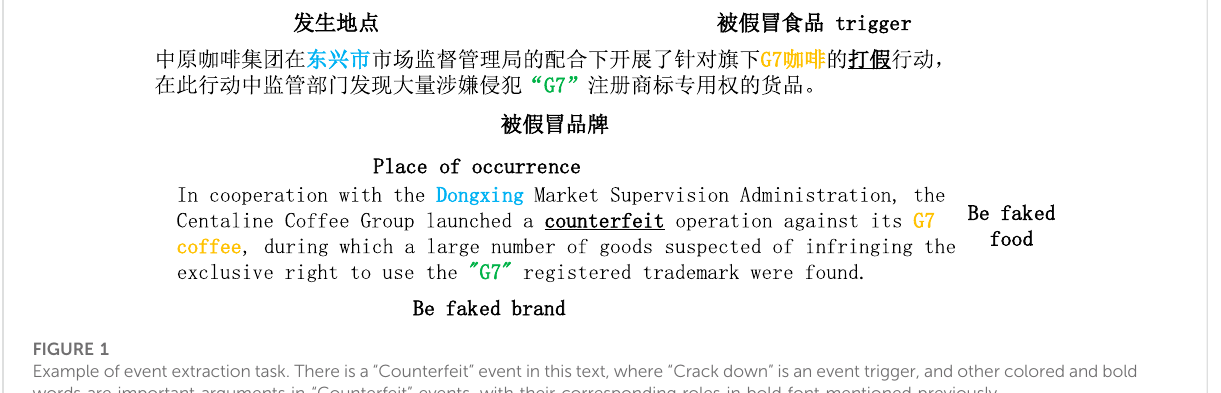
FIGURE 1 Example of event extraction task. There is a “ Counterfeit ” event in this text, where “ Crack down ” is an event trigger, and other colored and bold words are important arguments in “ Counterfeit ” events, with their corresponding roles in bold font mentioned